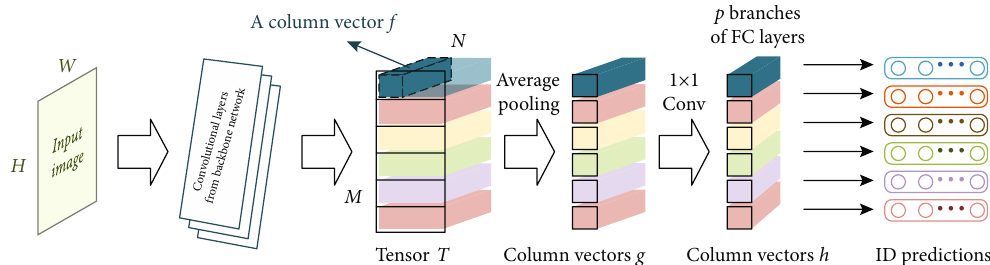
Figure. 3: Schematic diagram of the pool layer